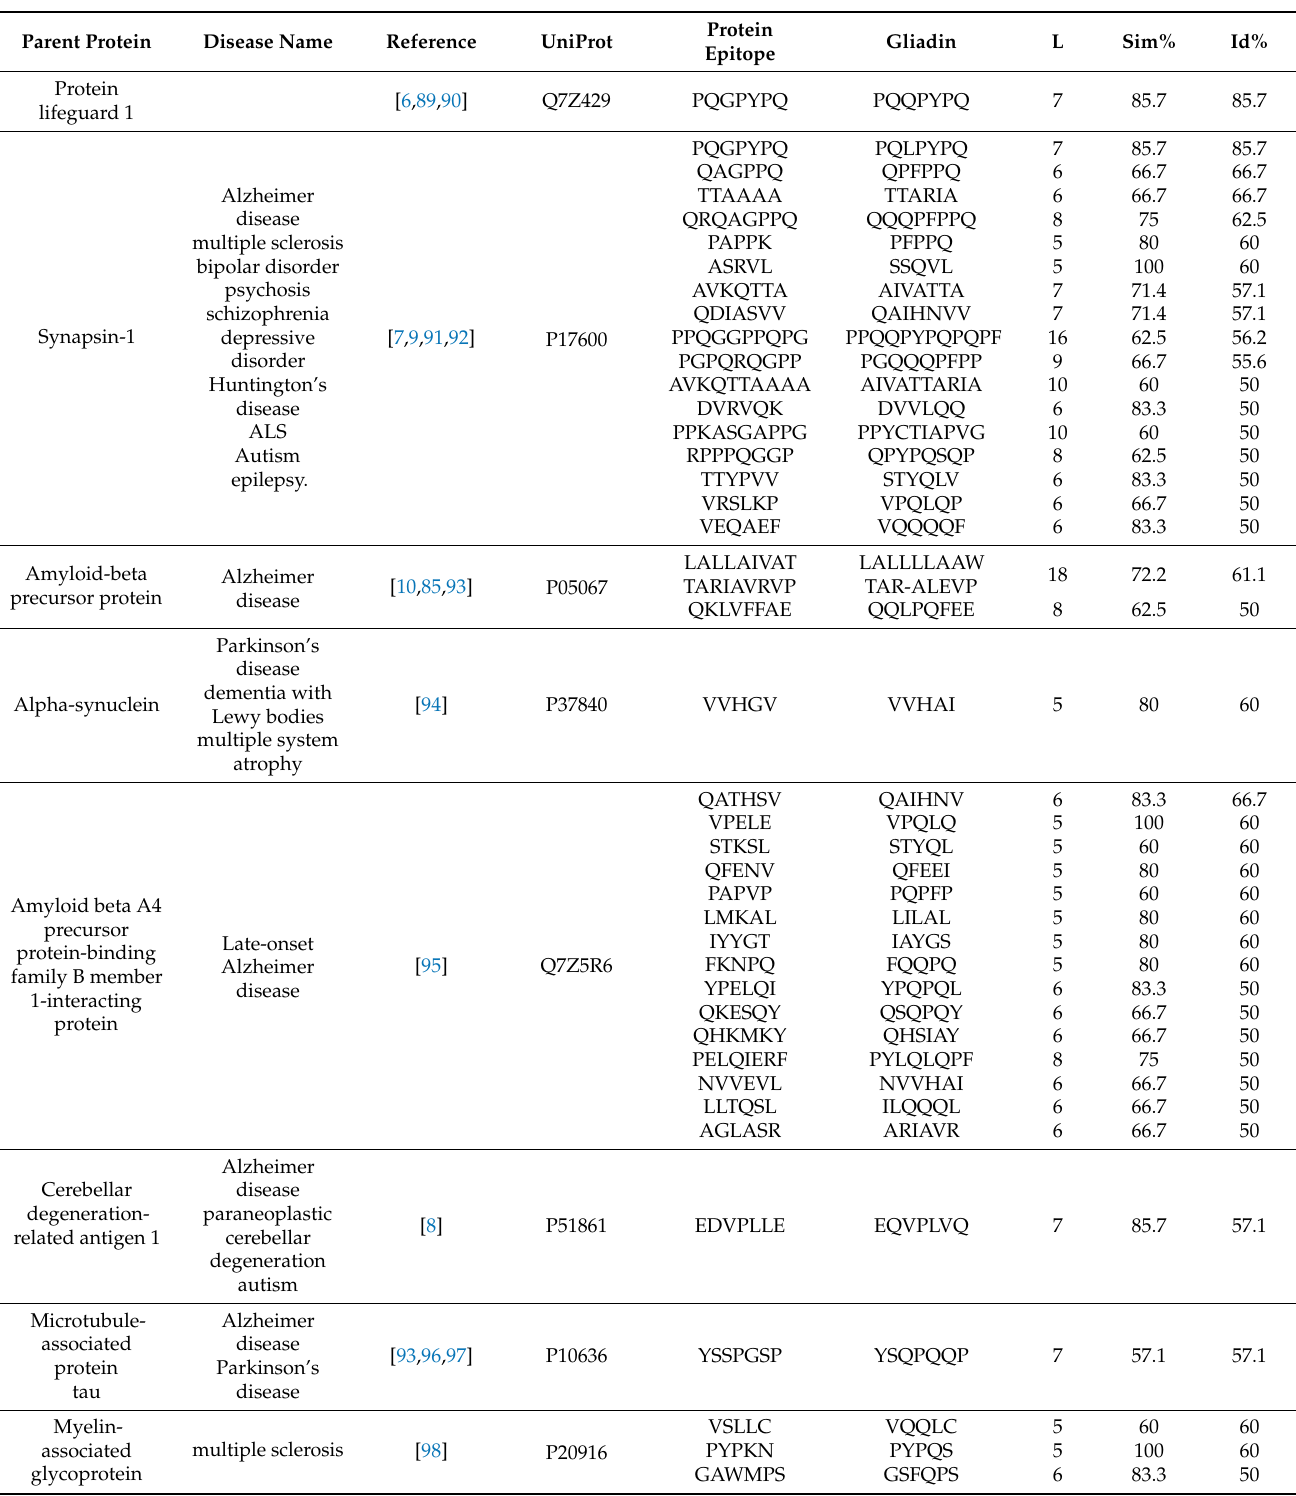
Table 3. Sequence homology between gluten/gliadin peptides and brain